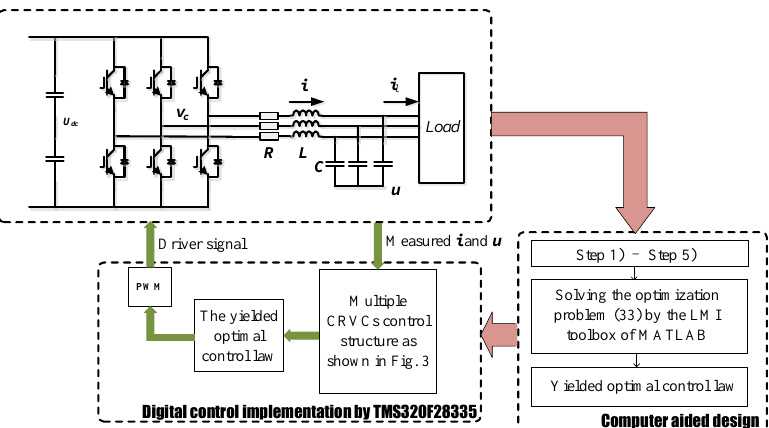
Figure 5. The schematic of the studied system. Table 2. Parameters of the three-phase invert.